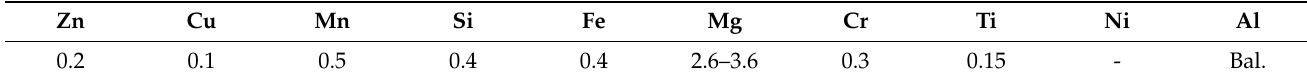
Table 1. Chemical composition of AA5754